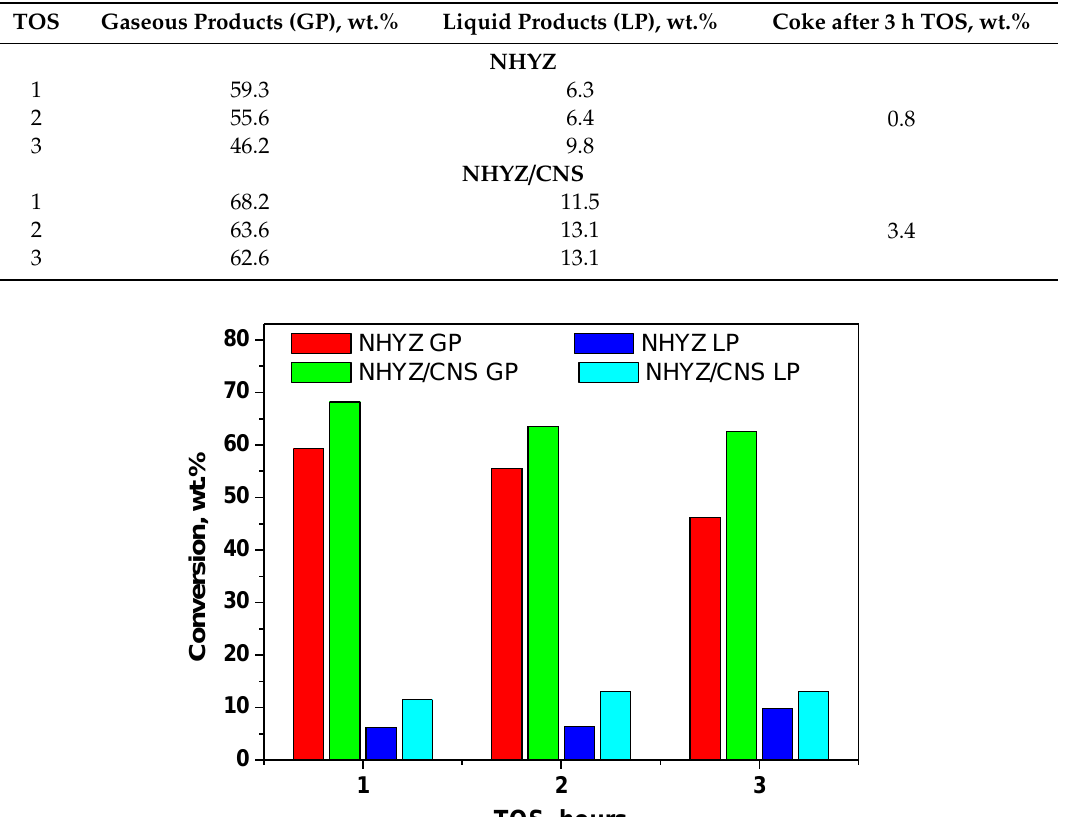
Figure 5. Conversion rates for NHYZ and NHYZ / CNS catalysts. Table 2. Gaseous and liquid products (GP and LP) for NHYZ and NHYZ / CNS catalysts.